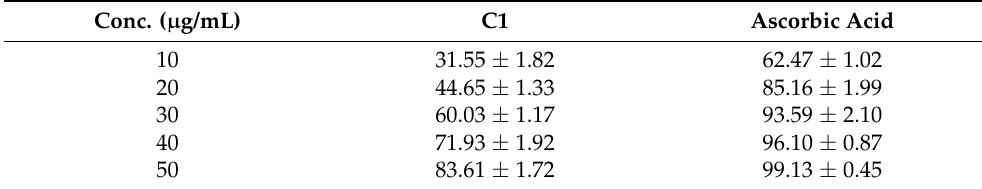
Table 5. DPPH radical scavenging activity of